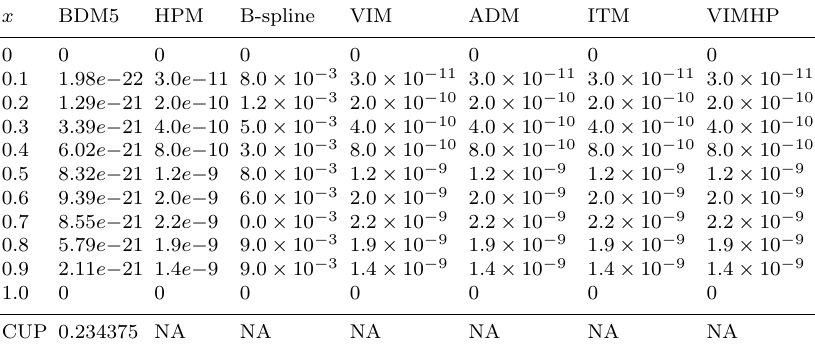
Table 5. Comparison of errors obtained with BDM5 and some methods in [8] on Example 1 with h = 1 / 10.